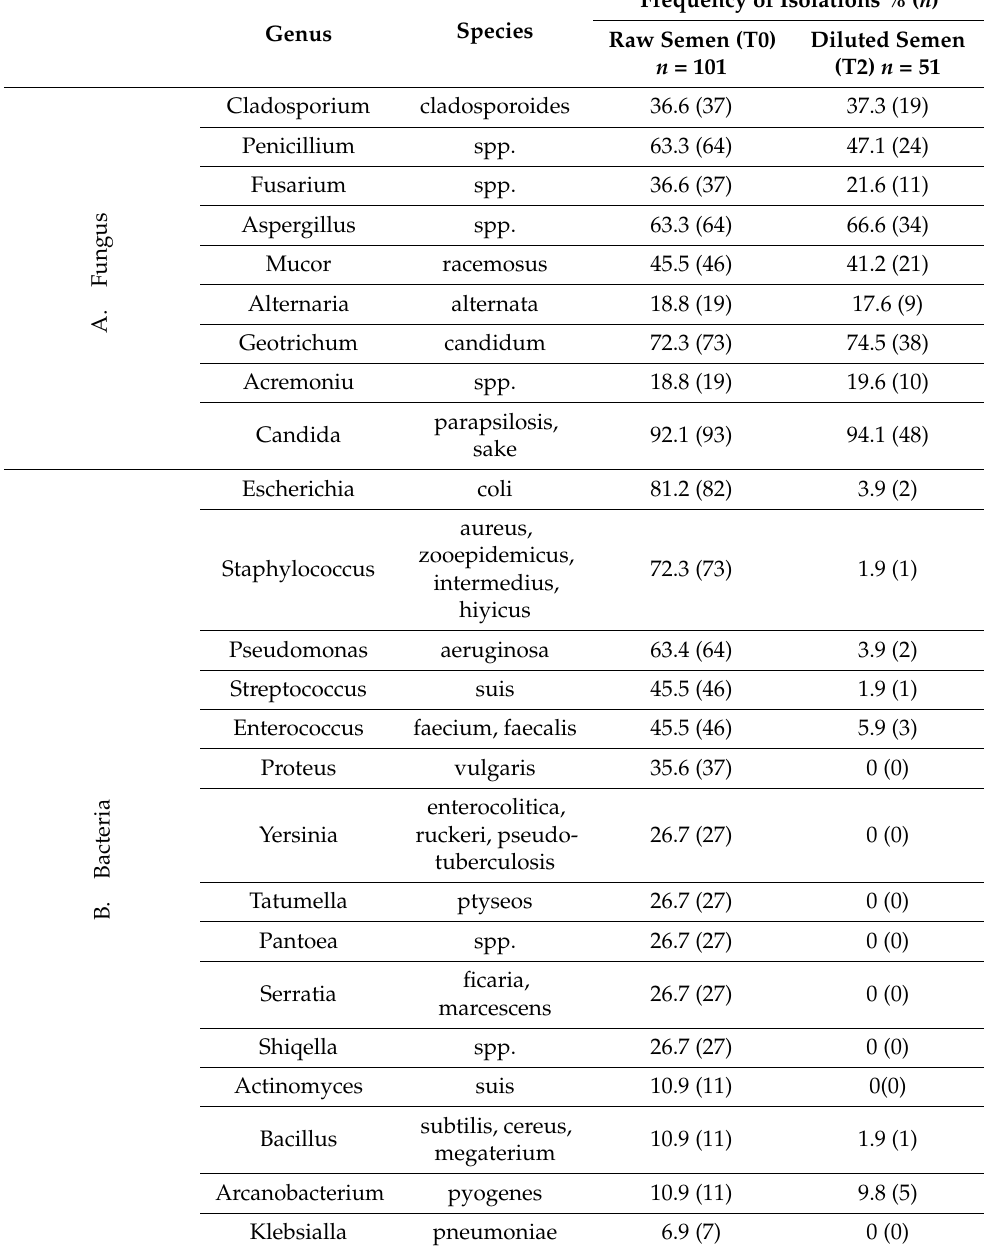
Table 2. Microbiological profile of raw boar semen. Identified bacterial and fungal genus and species: mycospermia (A) and bacteriospermia